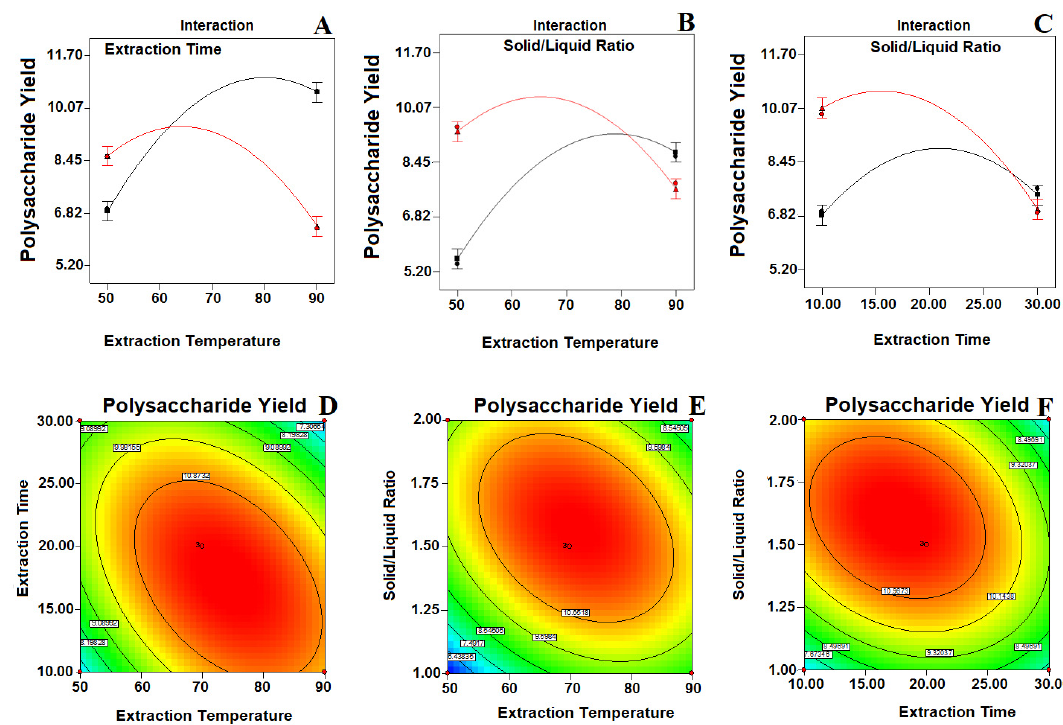
Figure 3. Response surface interaction and contour plots ( A , D ) showing the effect of the extraction time and extraction temperature; ( B , E ) solid–liquid ratio and extraction temperature; ( C , F ) solid liquid ratio and extraction time of the polysaccharide yield. The color intensity (red) in each figure represents the polysaccharide concentration.